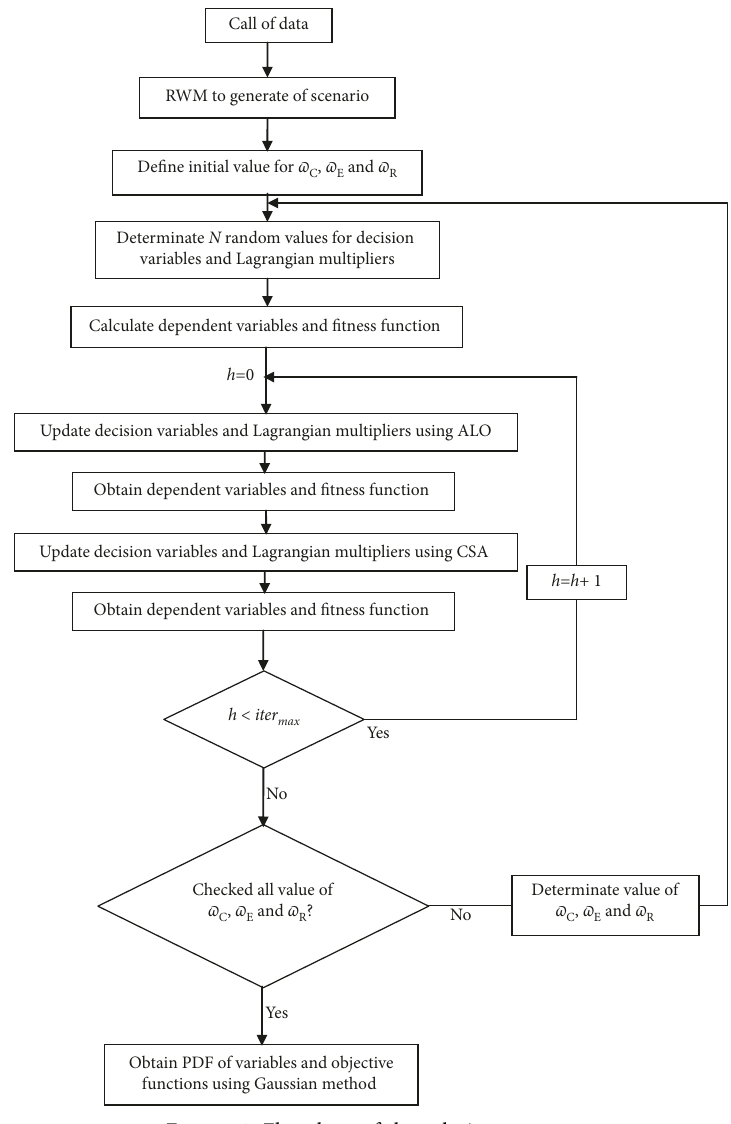
Figure 1: Flowchart of the solution process.